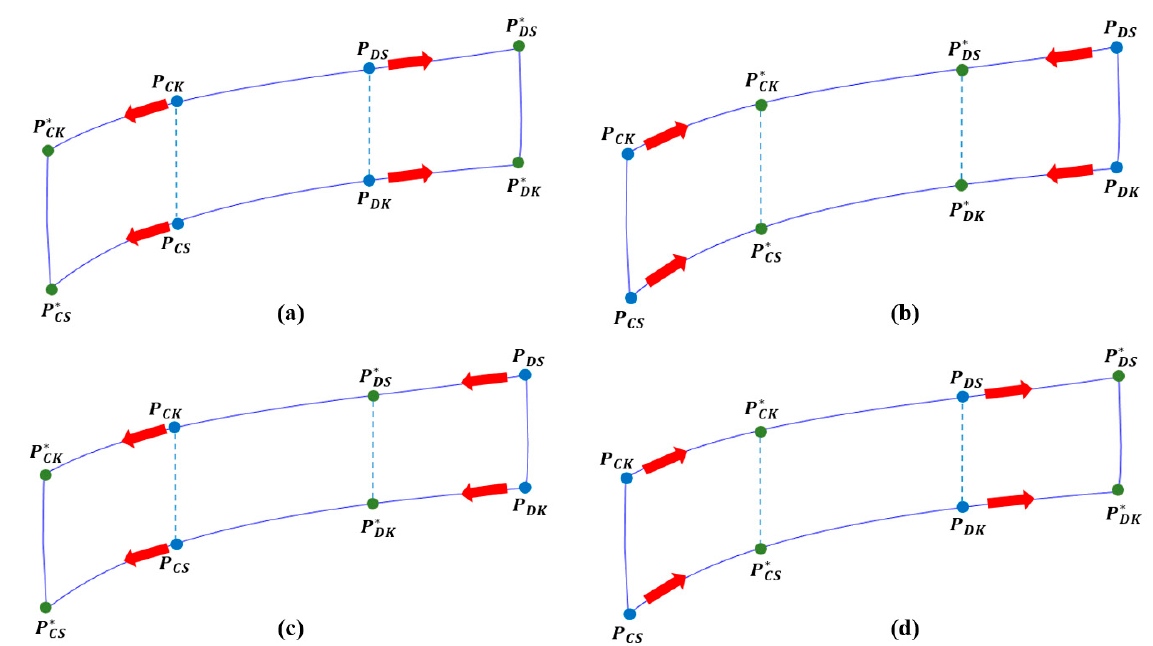
Figure 8. Four modes of the point detection method (PDM) according to charge and discharge status: ( a ) if the DOD is widened; ( b ) if the DOD is narrowed; ( c ) if the DOD range of movement is low; and ( d ) if the DOD range of movement is high.